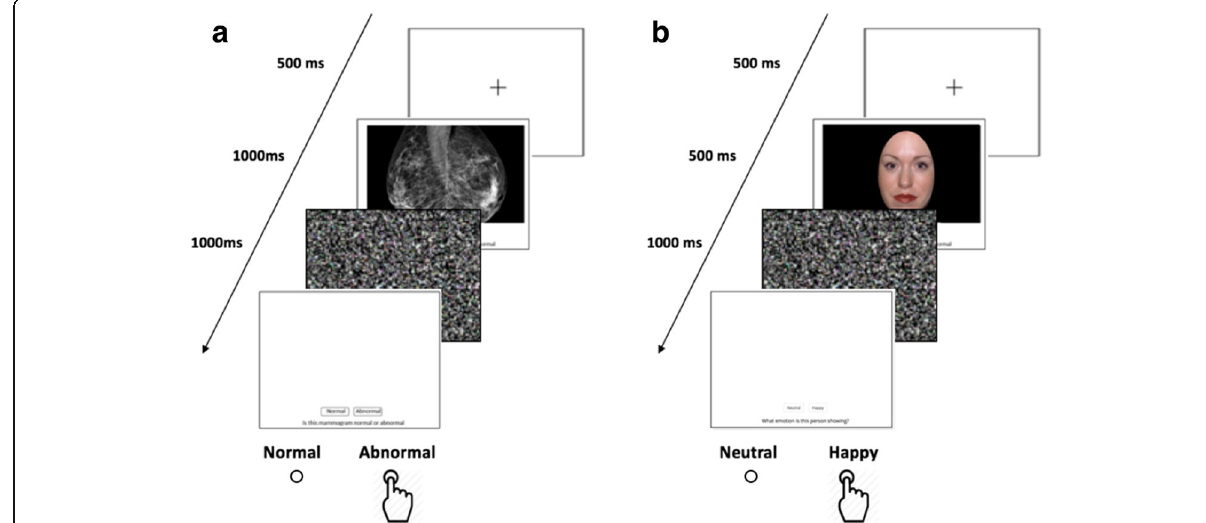
Fig. 2 Overview of the alternative forced choice paradigm blocks. a Mammogram block: determine if the viewed mammogram is normal or abnormal. b Face block: decide whether a presented face is happy or neutral